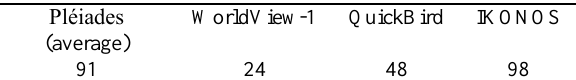
Figure 6. Error vectors at GCPs derived by RPC-orientation for stereo combination 283-284